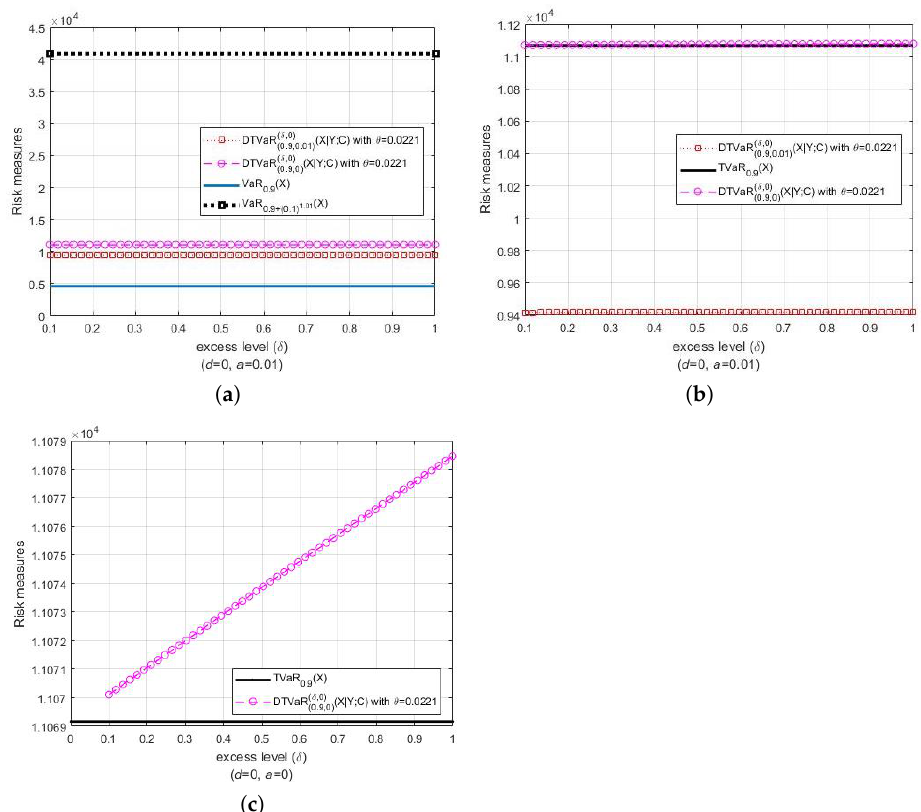
Figure 4. DTVaR of the target loss X with associated loss Y and its comparison with ( a ) VaR of X and ( b – c ) TVaR of X . Both X and Y are Pareto distributed with ˆ γ 1 = 2.0468, ˆ β 1 = 2203.9, whilst FGM copula parameter estimate is ˆ θ =